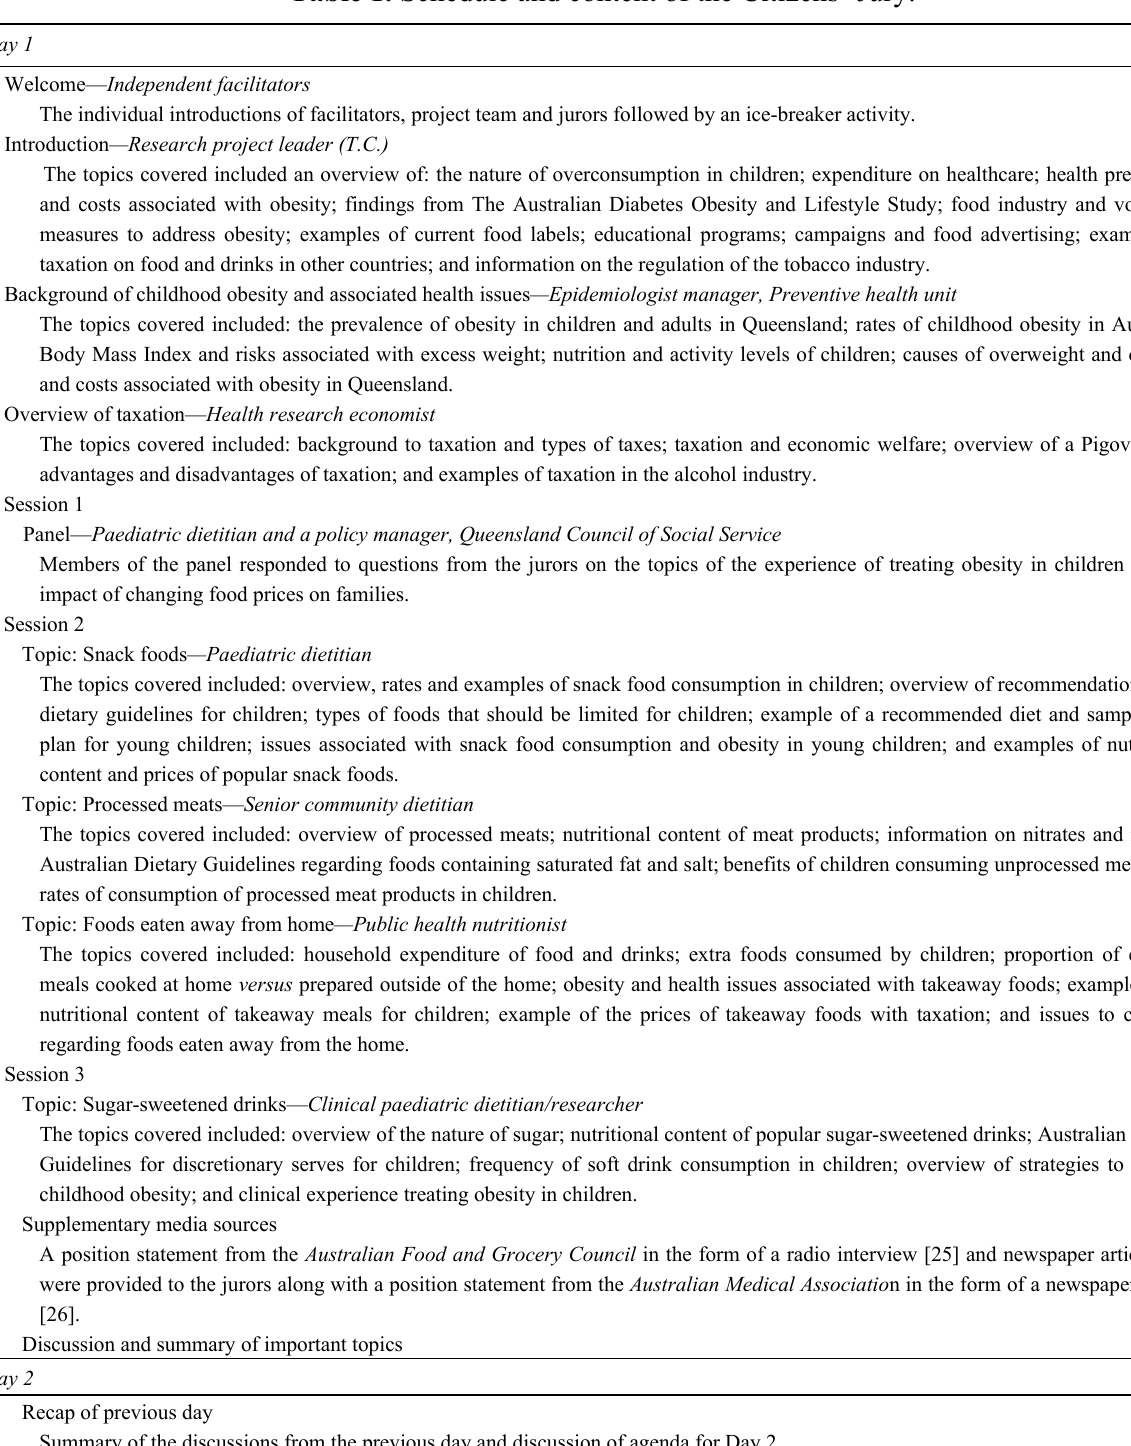
Table 1. Schedule and content of the Citizens’